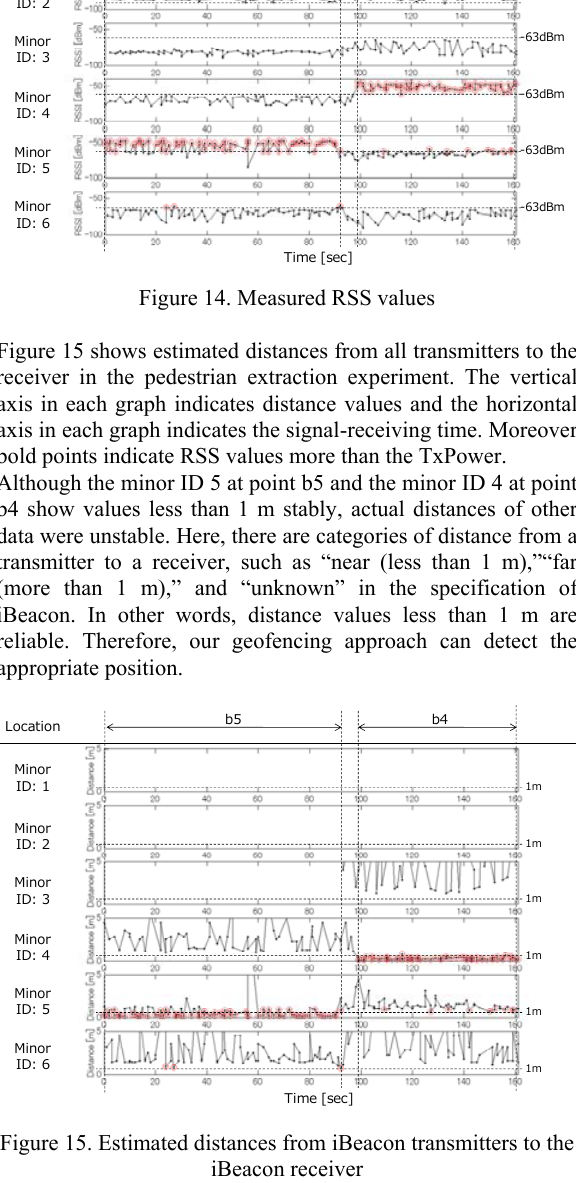
Figure 13. Extracted pedestrian data overlaid with 3D map